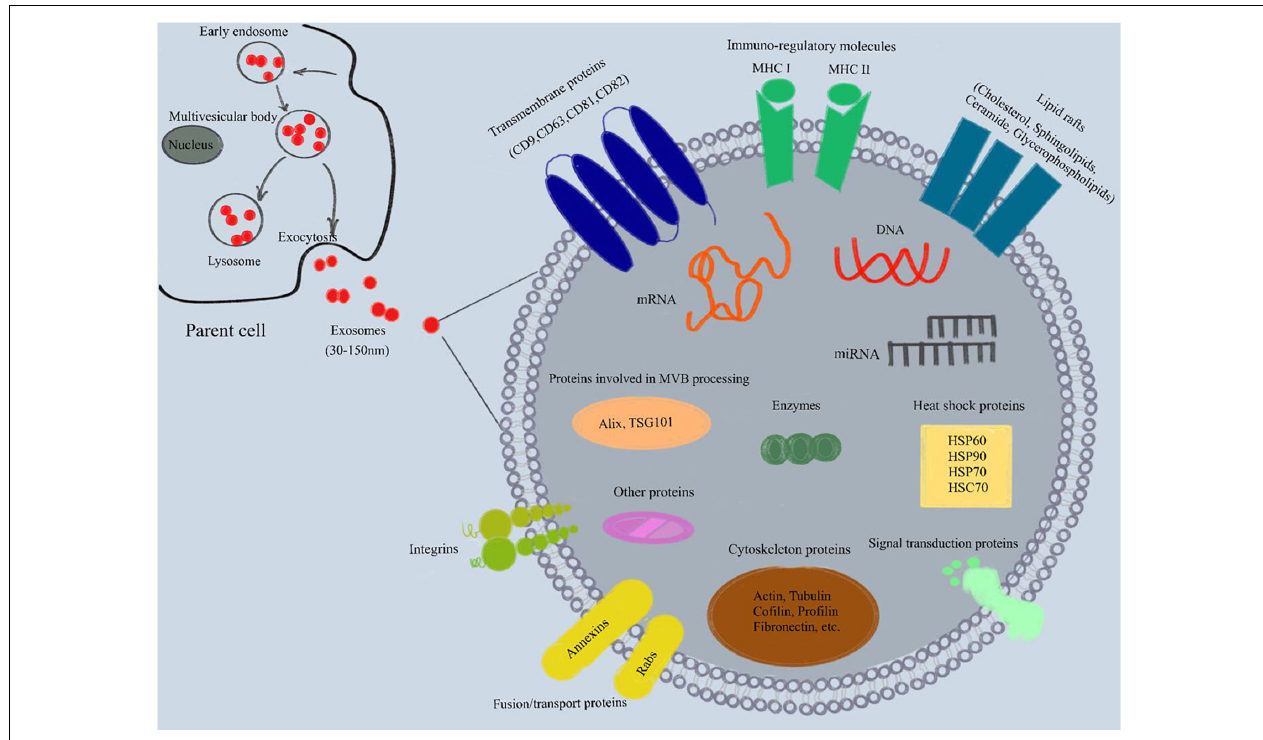
FIGURE 1 | Composition of exosomes. Exosomes are lipid bilayer vesicles with a diameter of 30–150 nm, which can carry specific proteins, lipids, mRNA, miRNA and other substances. In addition, exosome membrane is rich in lipid rafts (cholesterol, sphingolipids, ceramide and glycerophospholipids). Exosome proteins include four transmembrane proteins (CD9, CD63, CD81, CD82), heat shock proteins (HSC70, HSP60, Hsp70, Hsp90), proteins involved in MVB processing (Alix, TSG101), cytoskeleton proteins (actin, tubulin, cofilin, profilin, fibronectin, etc.), fusion/transport proteins (Annexins, Rabs), integrins, signal transduction proteins, immune regulatory molecules (MHC I and II) and various metabolic enzymes. MHC, major histocompatibility complex; mRNA, messenger RNA; miRNA, microRNA; MVB, multivesicular